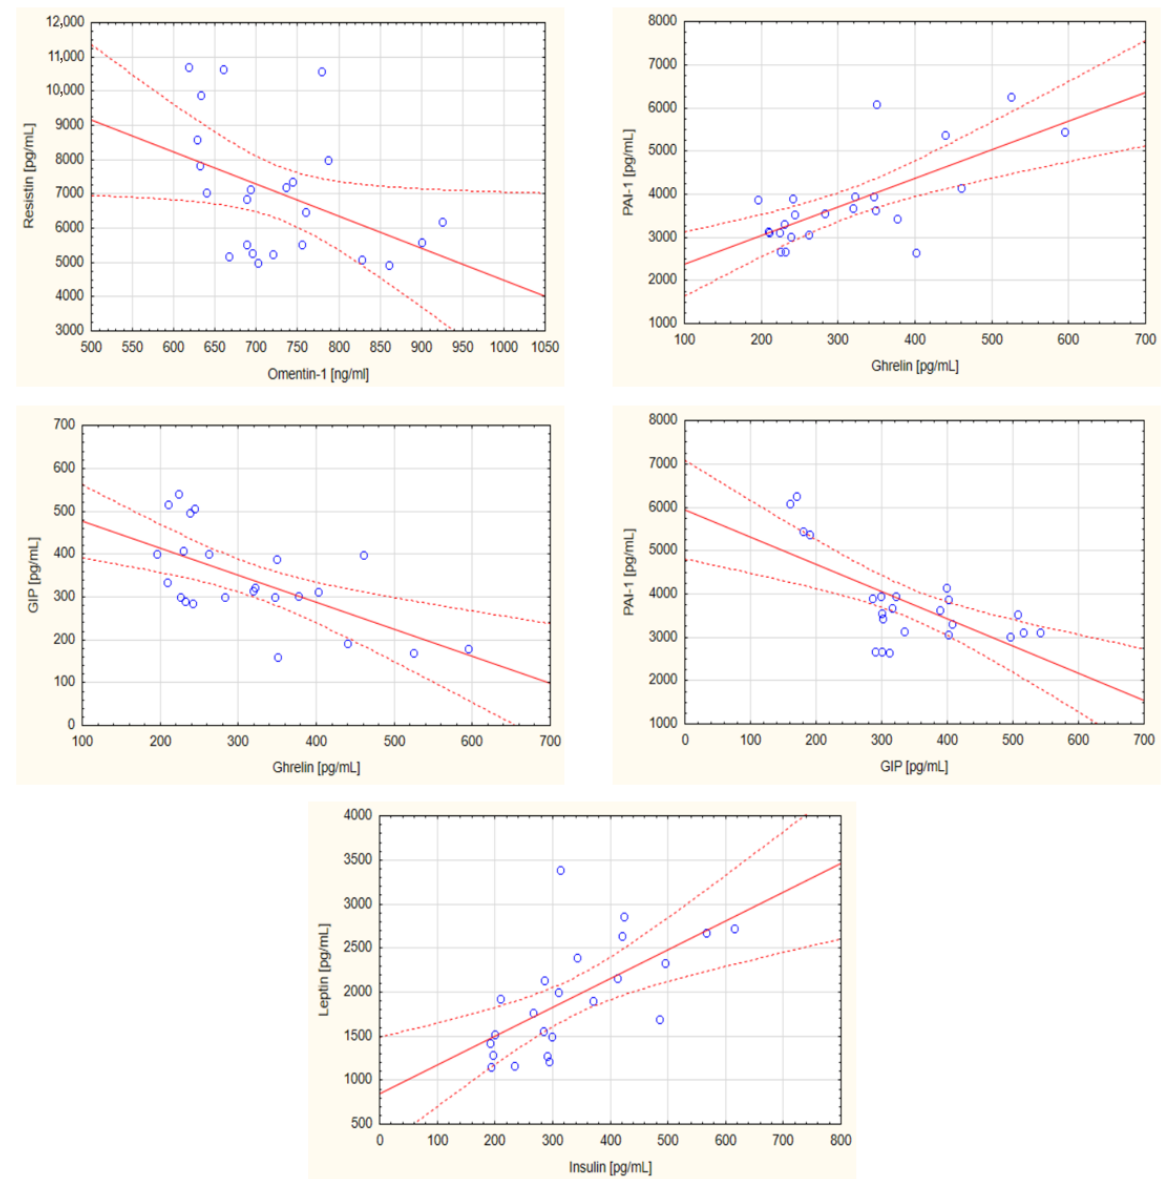
Figure 1. Statistically significant correlations between selected biochemical parameters in the nor- mal body mass index group of head and neck cancer patients. Abbreviations used: GIP: glucose- dependent insulinotropic polypeptide; PAI-1: plasminogen activator inhibitor-1. The regression line is marked with a solid line, while the confidence intervals of 0.95 are marked with a dashed line. P < 0.05 was considered as statistically significant.